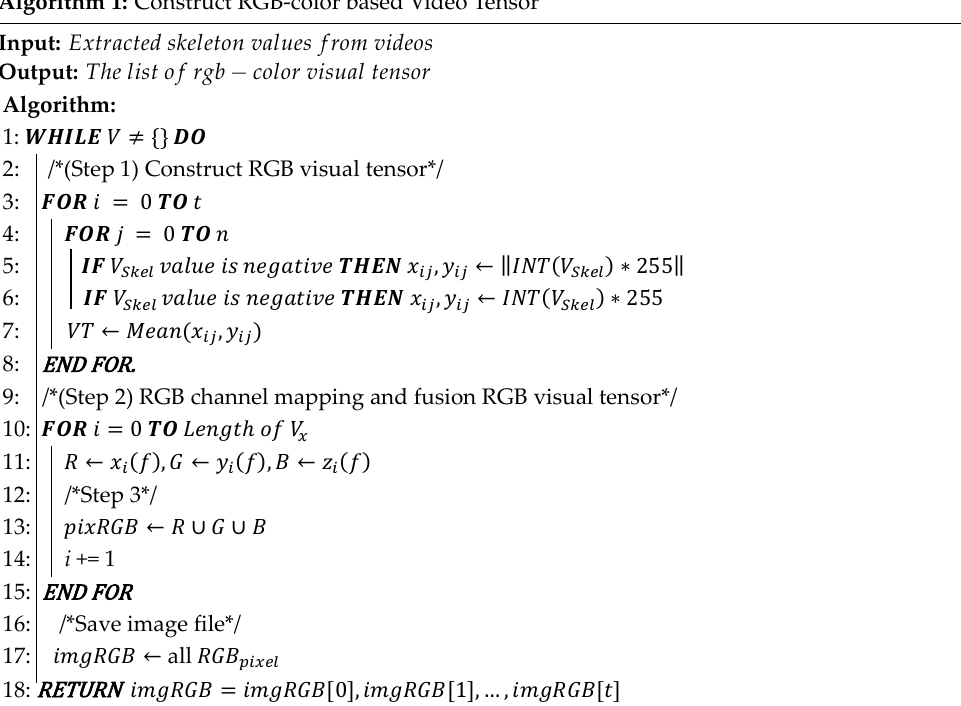
Algorithm 1: Construct RGB-color based Video Tensor